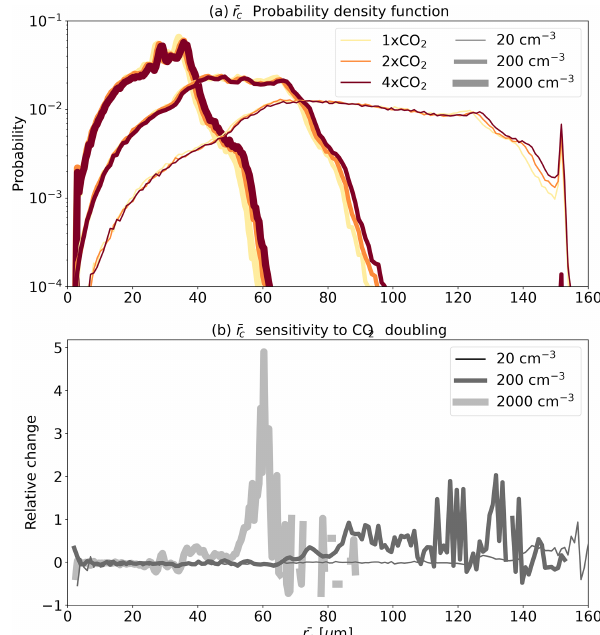
Figure 7. Probability density functions (PDFs) of cloud droplet mean radii ( r c ) for the different simulations (a) and the mean sensitivity of the r c PDF to a doubling of the CO 2 concentration based on the three combinations available for each N a condition (2 × CO 2 − 1 × CO 2 , 4 × CO 2 − 2 × CO 2 and (4 × CO 2 − 1 × CO 2 ) / 2) (b) , calculated for the heights around which the cloud droplet effective radii reach a maximum (1950m) and using 3-D files output every hour of the last 150d of the simu- lations. Note the logarithmic scales for the y axes of (a)